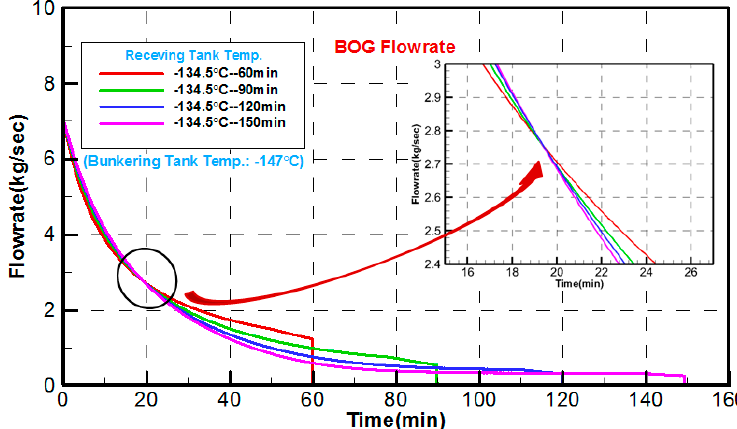
Figure 4. BOG flow rate variation based on different bunkering time limits.